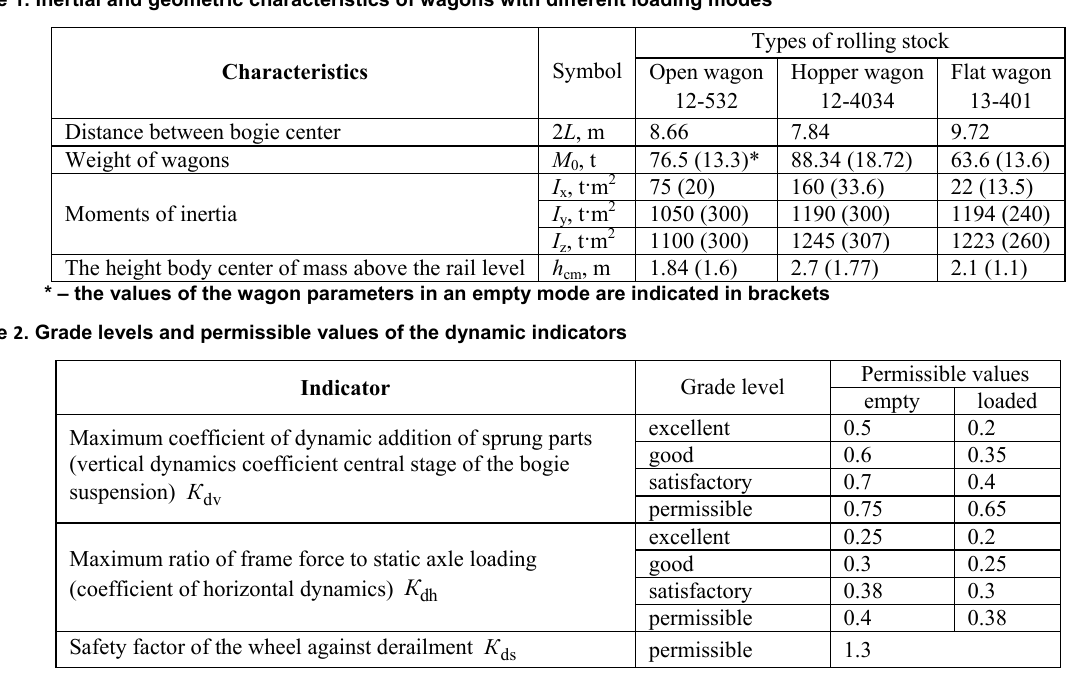
three types of rolling stock have almost the same coefficients K in the loaded mode, but in the R =600 m dv curve, the open wagon and the flat wagon have the best vertical dynamics indicators in the speed range 50-70 km/h in the empty mode (Fig. 10, b), and also excluding for the speed of 70 km/h in the loaded mode. These wagon types have a lower mass and a lower center of mass than a hopper wagon.